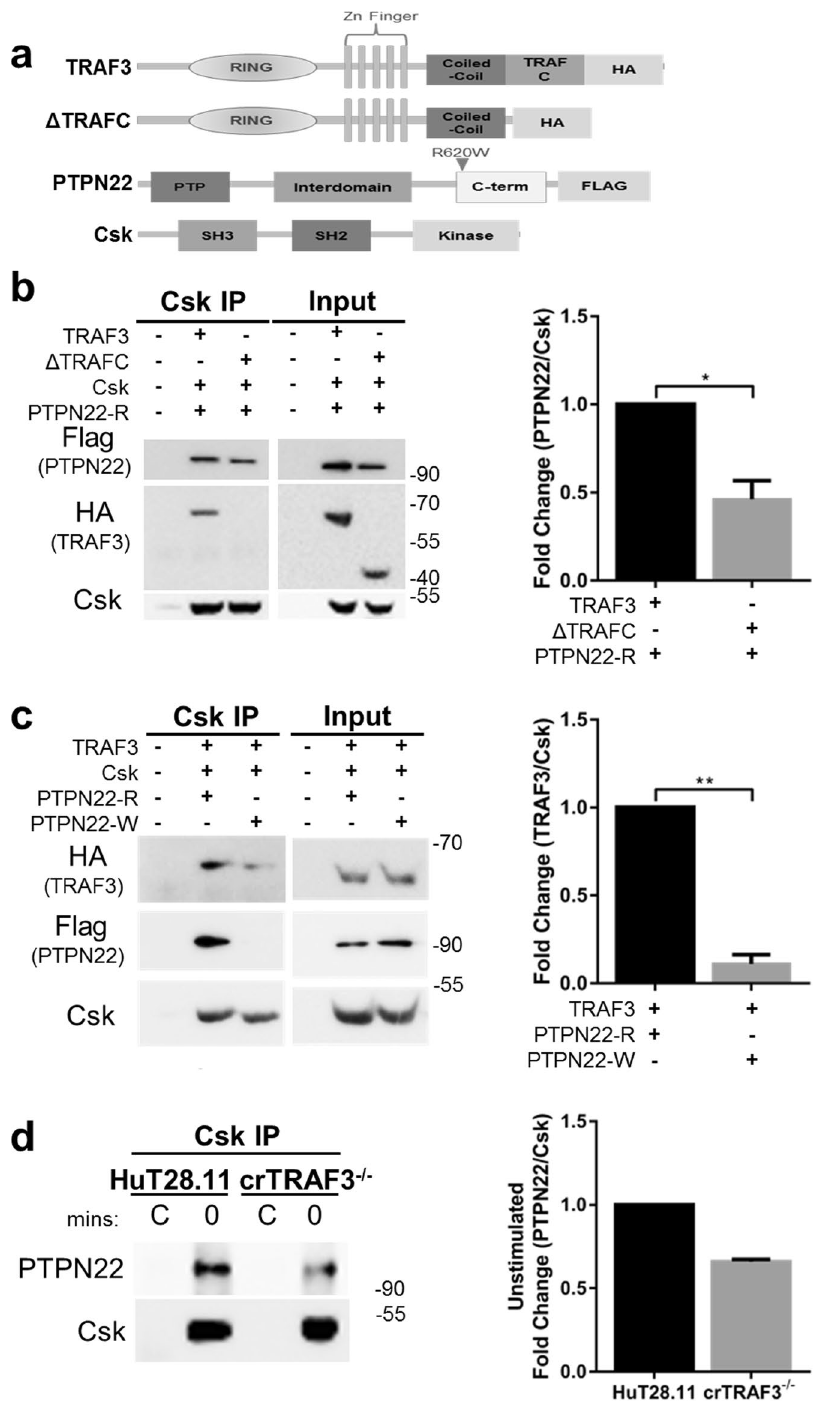
Figure 4. TRAF3, PTPN22 and Csk association. ( a ) TRAF3, PTPN22 and Csk constructs used in HEK 293T cell transfections. ( b and d ) Immunoprecipitation of Csk from transfected HEK 293T cell lysates is shown at left, with total cell lysate input prior to immunoprecipitation shown at right. Western blot analysis was performed for the specified proteins. Quantification of bands was performed by dividing the relative expression of PTPN22 by Csk ( c ) or TRAF3 by Csk ( e ). The obtained values for the cells transfected with the mutant plasmids were then normalized to the values obtained for cells transfected with the control wild type plasmids. ( d ) From unstimulated crTRAF3 − / − (clone 45) T cell whole cell lysates, an immunoprecipitation for Csk was performed as described previously. Western blots were cropped to focus upon specific proteins indicated. Full-length blots are presented in Suppl. Fig. S5. C = Control samples, cells were unstimulated and no immunoprecipitation Ab was added, to detect any nonspecific binding to the protein G beads. Error bars indicate SEM of three experiments. A Wilcoxon matched-pairs signed rank test was performed to determine statistical significance in b and c ; * P < 0.05, ** P < 0.01. Data are representative of 3–8 independent